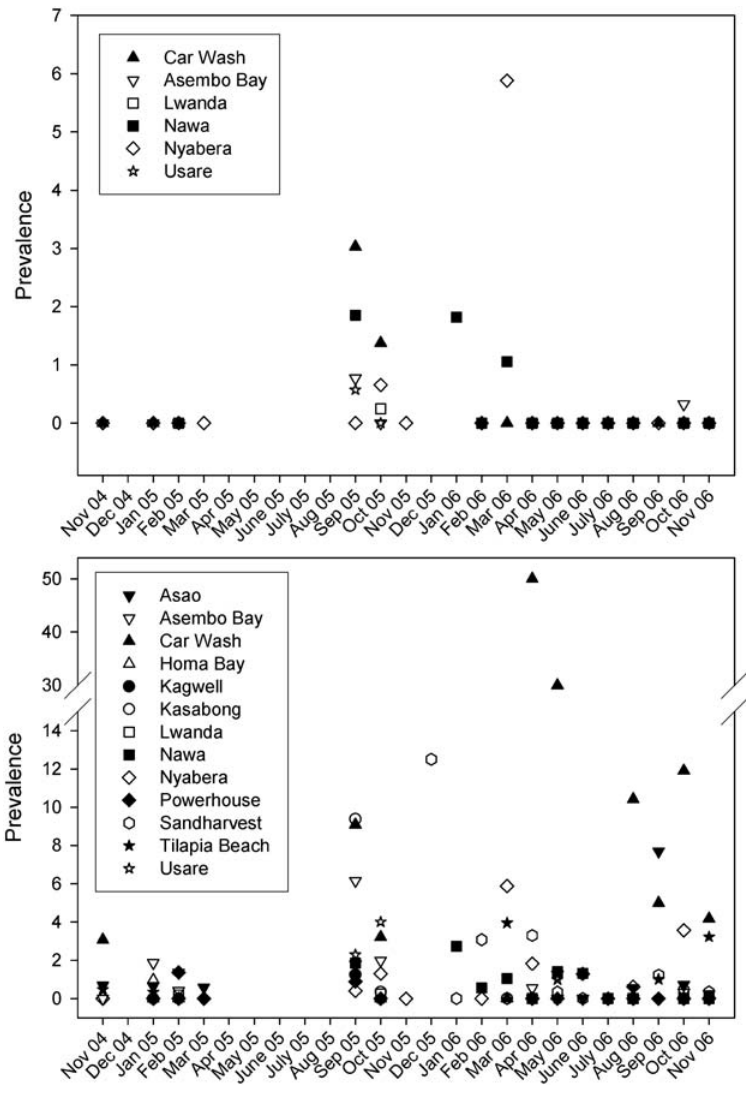
Figure 3. Prevalence (percent of snails infected) of S.rodhaini (top) and S.mansoni (bottom) at various sites in the Lake Victoria basin of Kenya over a 2 year period. Blank spaces indicate that either snails were not present or no collections were made.